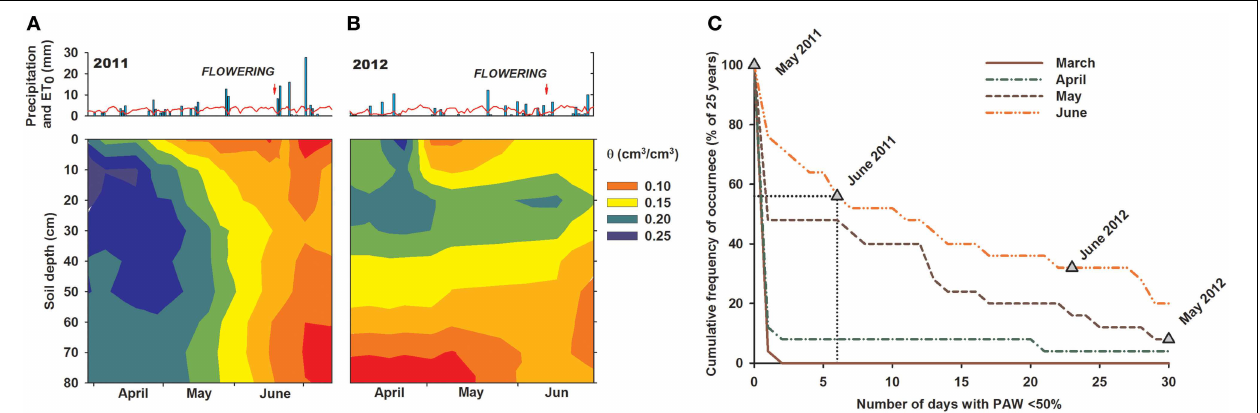
FIGURE 1 | (A,B) Daily rainfall and potential evapotranspiration (ET0) at the experimental site over 2011–2012 (Modified after Nakhforoosh et al., 2014), and (C) cumulative frequency of occurrence of days with < 50% plant available water (PAW) over 1m soil profile depth during growing season. Calculation based on annual vs. longtime soil water content simulation.